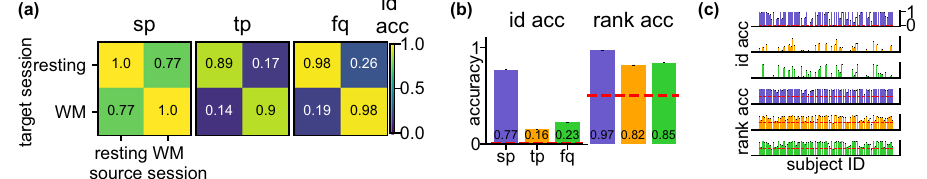
Fig. 5 Consistent sp for cross-task identi fi cation on Human Connectome Project data. a Heat maps of the cross-task identi fi cation accuracy using the three features on HP data. Both resting and working-memory (WM) data were recorded on the same day. For one identi fi cation run, the features of each individual were computed using randomly sampled trials ( N = 200) from both the source and target session. Each grid represents the average accuracy across 77 individuals and 100 identi fi cation runs. The within-task accuracy (diagonal entries) were computed using the same source-target splitting procedure as on the Harry Potter data to avoid data leakage. b Average cross-task identi fi cation accuracy and rank accuracy for each feature on HCP data. Within-task accuracy (resting vs. resting, WM vs. WM) are excluded in computation. Error bars are the SEs across cross-task sessions ( N = 2), individuals ( N = 77), and identi fi cation runs ( N = 100) and are invisible due to small values. The red dashed lines are the chance level for the identi fi cation accuracy ( ¼ 1 ) and rank accuracy ( ¼ 39 ). c Identi fi cation (upper three rows) and rank (lower three rows) accuracy on HP data by individual. Within-task accuracy 77 77 were excluded in computation. Error bars are the SEs across cross-task sessions ( N = 2) and identi fi cation runs ( N = 100) and are invisible due to small values. The red dashed lines are the same as in ( b ). These results indicate that sp is consistent even when performing different tasks (resting vs WM) in the source and target